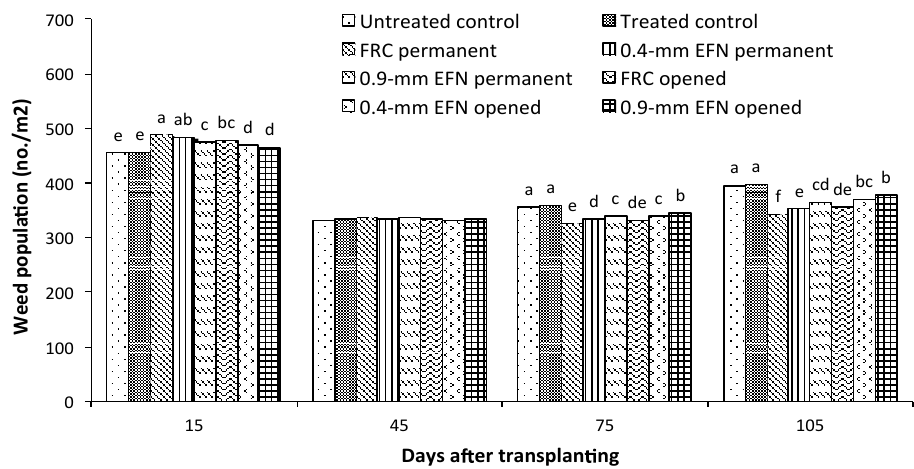
Figure 1. Effects of floating row covers (FRC) and eco-friendly nets (EFN) on weed population trends during tomato production. Values shown are averages for two growing seasons (May to October 2011 and October 2011 to March 2012). Data points within the same date with no letter or the same letter are not significantly different at p ≤ 0.05. Untreated control had no pesticide applied, treated control was sprayed with pesticides, permanent is where the FRC or EFN were covered throughout except during crop maintenance periods, and opened is where the FRC or EFN were opened thrice a week from 9:00 am to 3:00 pm.